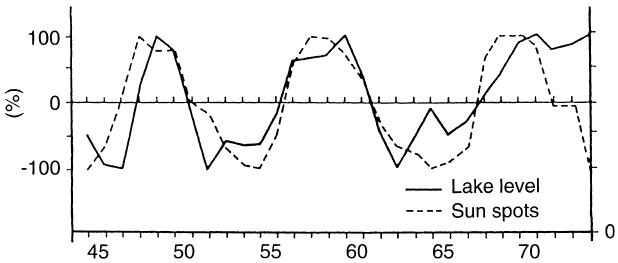
Fig. 4. Lake level relationship to number of sun-spots during 1944–